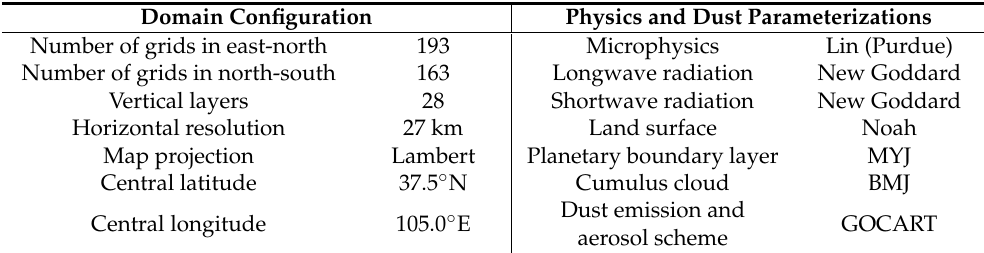
Figure 1. The simulation domain of the WRF-Chem model and the meteorological (red triangles) and air quality (black circles) observation sites. Table 1. The WRF-Chem model configurations.